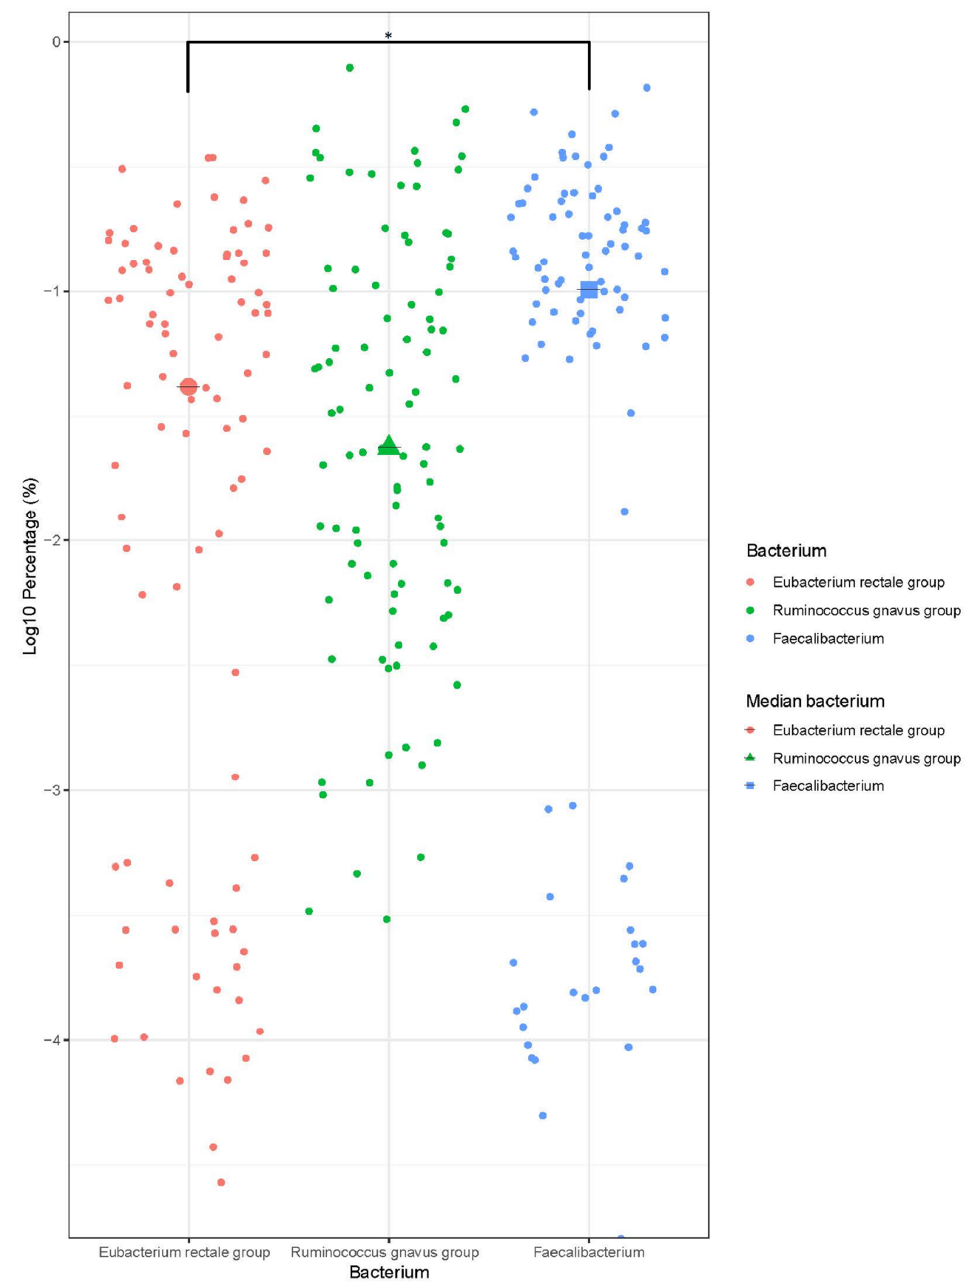
Figure 3. Relative abundance of E. rectale , R. gnavus, and Faecalibacterium, at 12 months. The dot plot shows the relative abundance (Log10 of percentage abundance) and median of the E. rectale group, R. gnavus group, and Faecalibacterium, at 12 months of age for all infants. The asterisk (*) represents a significant difference in relative abundance ( p < 0.05, Wilcoxon rank sum test, FDR correct by Benjamini–Hochberg method) between the bacteria.